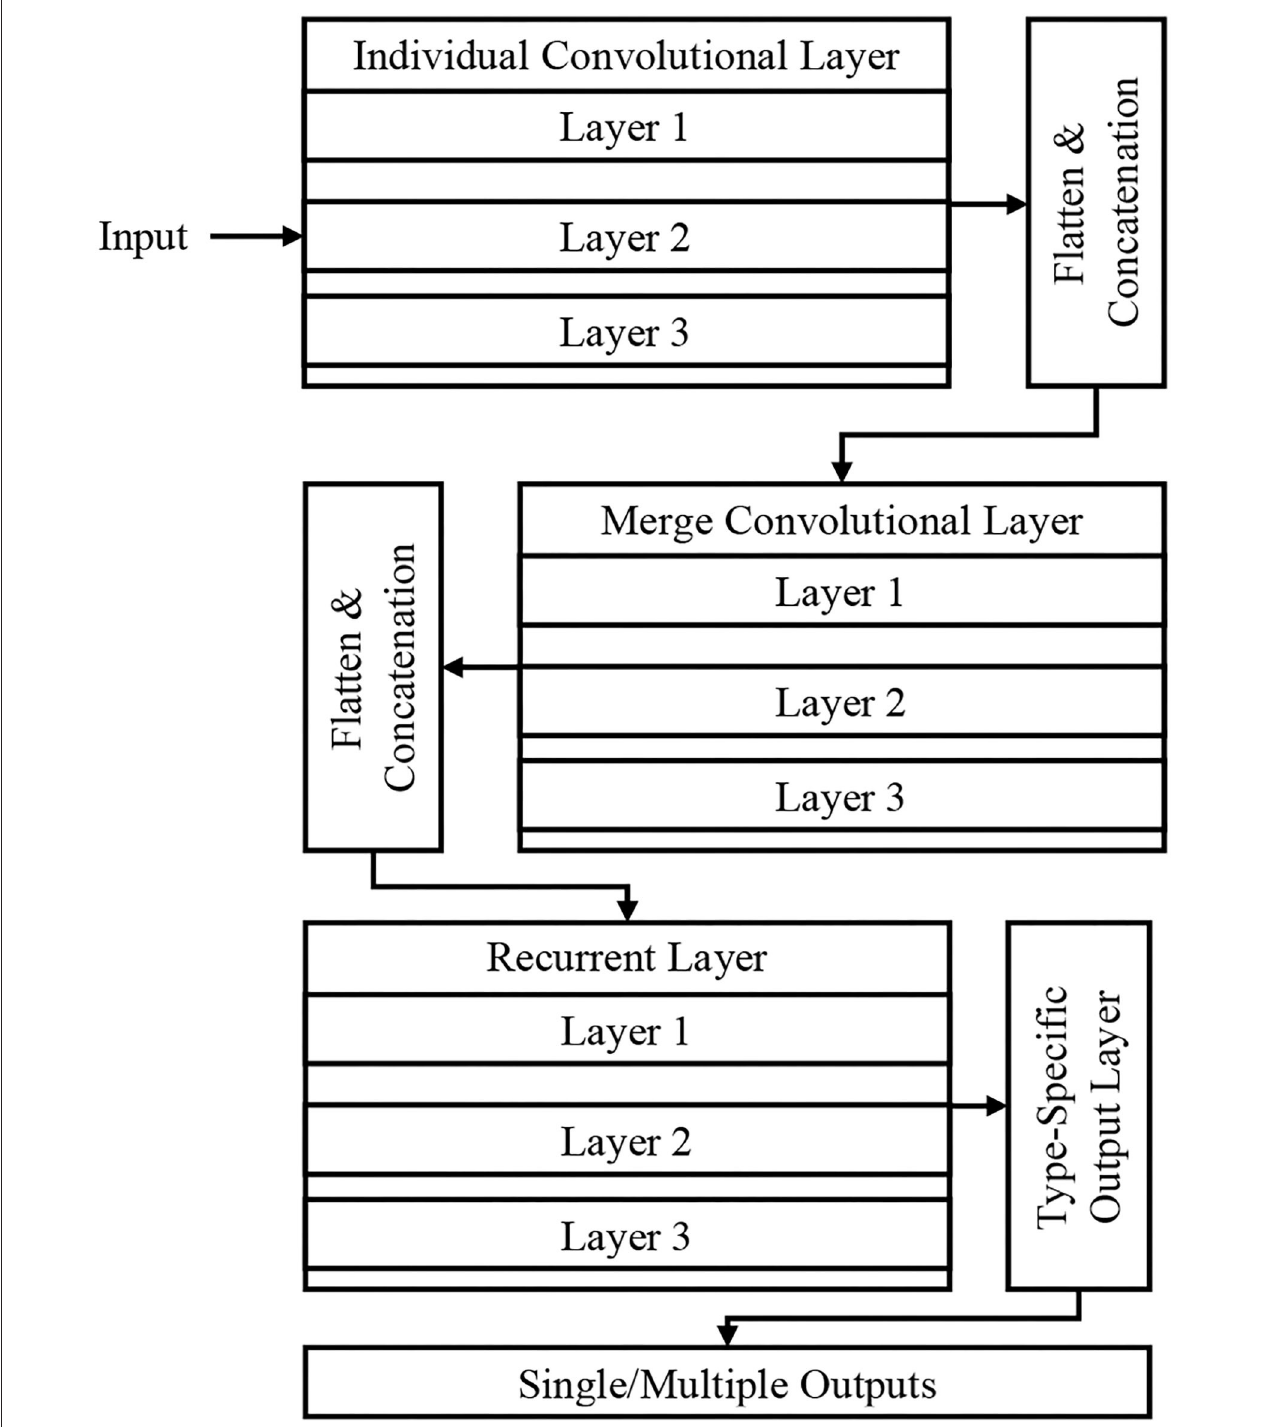
FIGURE 2 | Proposed DeepSense deep neural network (DNN) architecture.